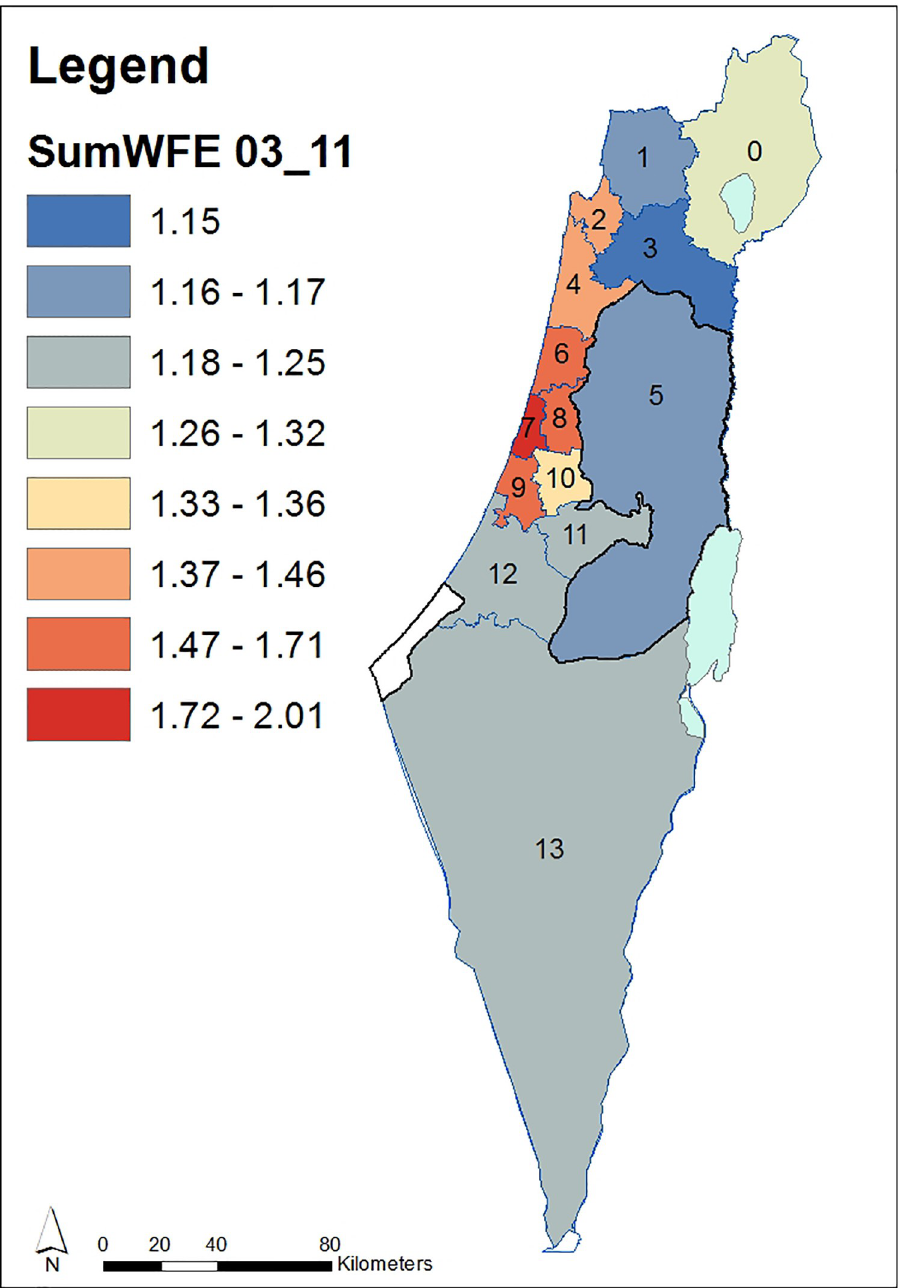
Fig 6. District WFE evolution indicators normalized per year of the trans-country minimal expenditure Volume over the period 2003–2011. Districts enumerations are as in Fig 3. Country borders and district borders have been downloaded from ArcGIS Online [71]. For country borders see: ESRI, Israel Districts Layer–Ministry of Planning, https://www.arcgis.com/home/item.html?id=2749fad1b0bf45e484d5323e296e37cf (06/03/2021). For country districts see: ESRI, Israel Districts Layer–Ministry of Planning, https://www.arcgis.com/home/item.html?id= 927cfe72a31e4a05ab130526c1391acf (06/03/2021).